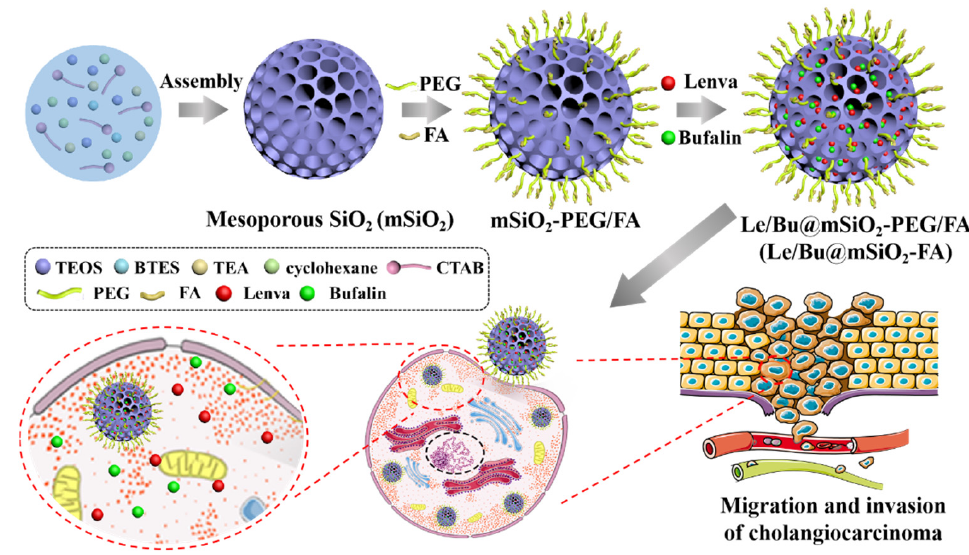
Figure 1. The synthesis process of Le/Bu@mSiO 2 -FA.